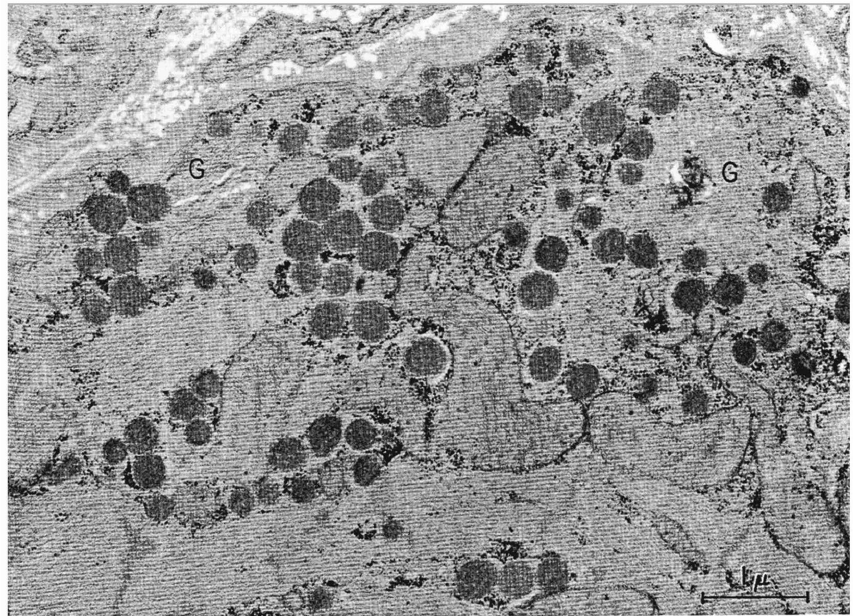
Figure 1. Granules (G) within atrial cardiomyocytes (taken from [12] with permission). As mentioned, granules are present in atrial cardiomyocytes. Ventricular myocytes, on the other hand, do not contain granules, at least not in ventricular myocytes from healthy hearts [21,22]. When ventricular myocytes are subjected to stress; however, their phenotype changes towards an atrial phenotype and begin to contain granules [23]. Our current knowledge of granules in the ventricular cells is still limited, but it is possible that the path from peptide synthesis to secretion follows a constitutive-like rather than a strictly regulated pathway. Some suggestions for storage of peptides in “normal” ventric- ular myocytes have been reported, where ventricular tissue, for instance, can store proforms of cholecystokinin (CCK), which is a gut hormone also expressed in the mam- malian heart [24,25]. Notably, ventricular cells are notoriously difficult to culture in vitro which has excluded detailed molecular studies of peptide storage and release. Our current understanding of endocrine ventricular cells is; therefore, fragmentarily based on whole organ studies and adynamic histology. 1.2. Translation A key event in translation of mRNA to propeptide is the removal of the signal pep- tide. The enzyme signalase cleaves an N-terminal fragment from the preprostructure while the translation occurs, and the signal peptide is supposedly then degraded. Signal peptides are often said to be molecular guidewires that ensure the ribosomal translation into the Golgi network. For the cardiac peptides, the preprostructures are thus non-exist- ent as independent structures. In contrast to the general concept that signal peptides are degraded, signal peptides from the natriuretic peptides are expressed and identifiable [26–28]. Moreover, fragments of the signal peptides are even released to circulation and can be quantitated in plasma. As to how these peptides leave the cardiomyocytes is still not resolved, but clinical data suggests that their release can be rapid and precede release from cellular apoptosis and membrane lysis. As signal peptides generally are highly hy- drophobic, it may be speculated that they are “carried” by another peptide or protein, perhaps by a granin.